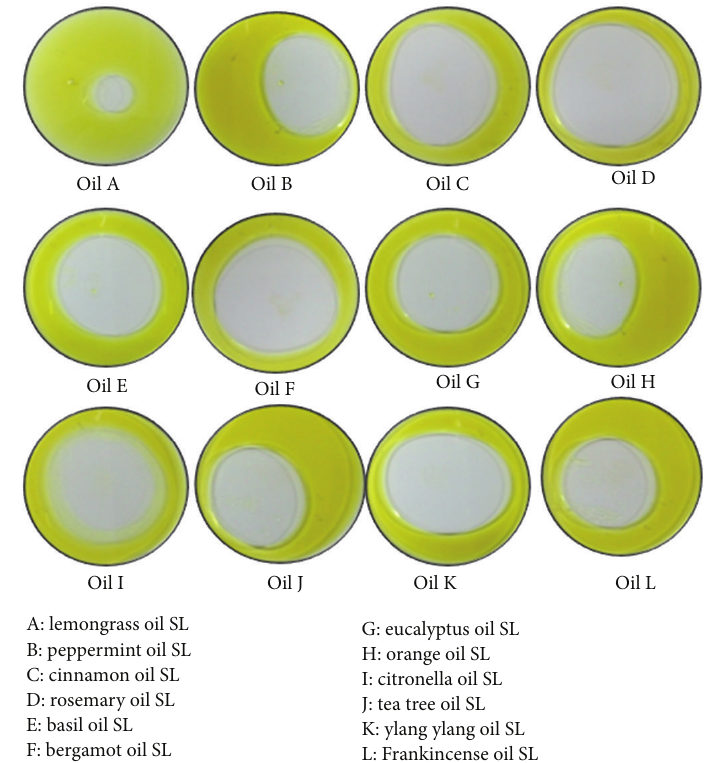
Figure 2: Oil displacement activity of the synthesized